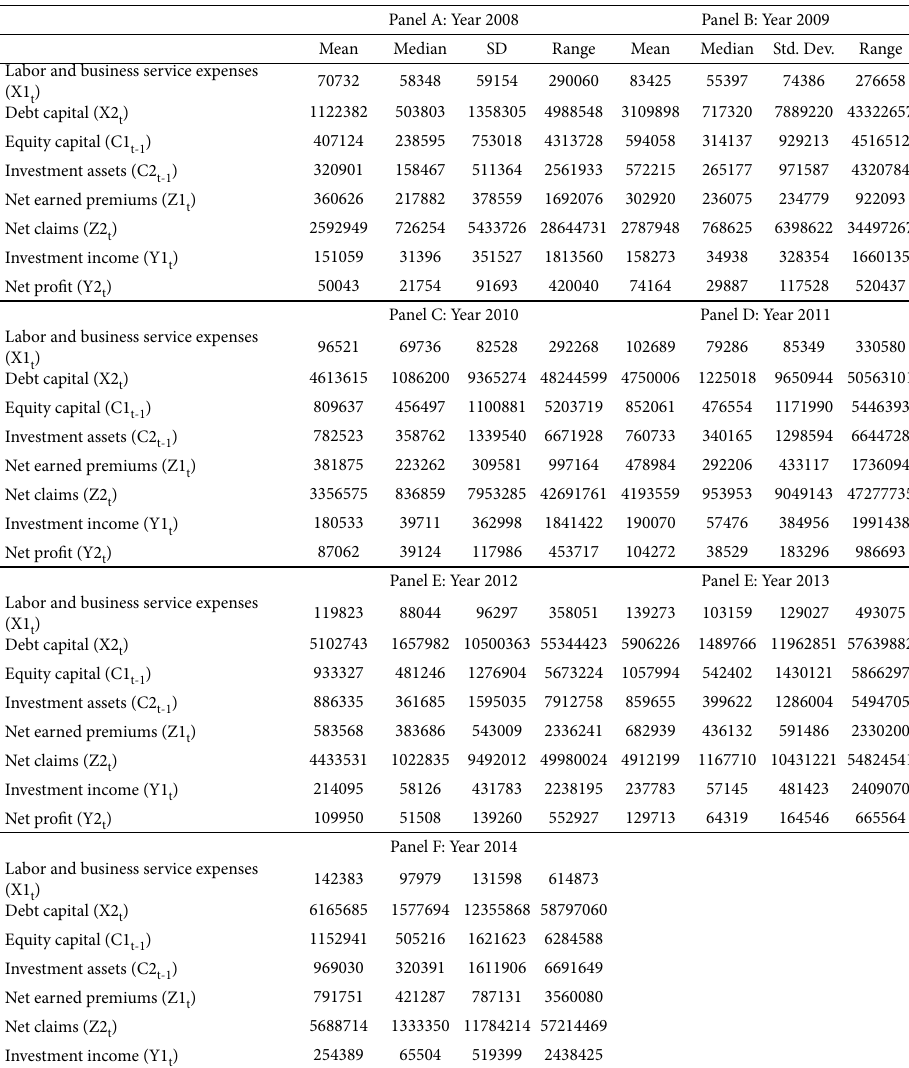
Table A1. Yearly summary statistics of the input, carry-over, intermediate, and output